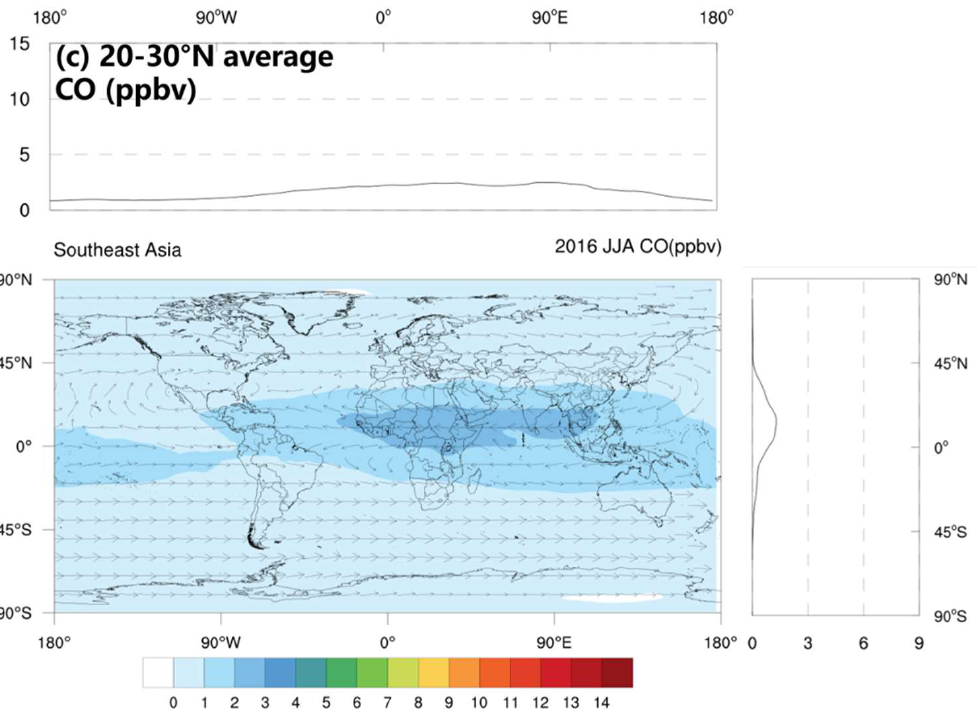
Figure 4. Effect of surface emissions on the 100 hPa CO concentrations in South Asia ( a ), East Asia ( b ) and Southeast Asia ( c ). At the top of the concentration graph are the average results for the latitudes with the highest concentrations of CO. The right side of the concentration diagram shows the difference between the high-value and nonhigh-value regions of CO at the different latitudes. Units: ppbv.